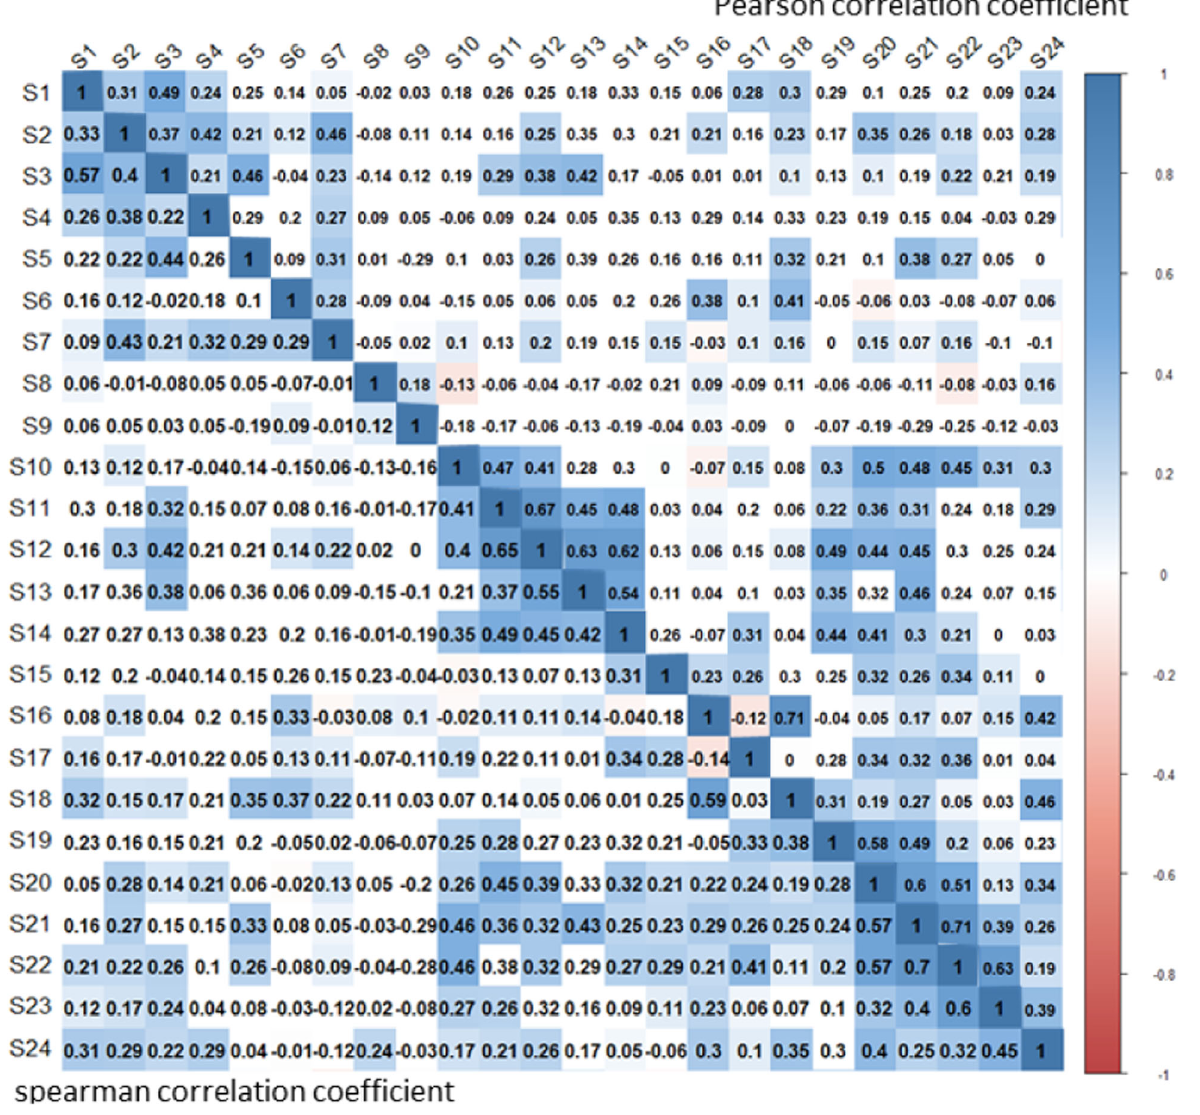
Fig. 2 The correlation coef fi cients between the 24 variables of the multiple-Item scale questions on satisfaction (see Table 3 for details of the items). On the top right, the Pearson method was used to calculate the correlation coef fi cient and on the bottom left, the spearman method was used. After comparing the results of the two methods, there is barely a detectable difference. Signi fi cance correlations are pointed out by colour according to the colour scale on the right. A signi fi cance level of 0.01 was